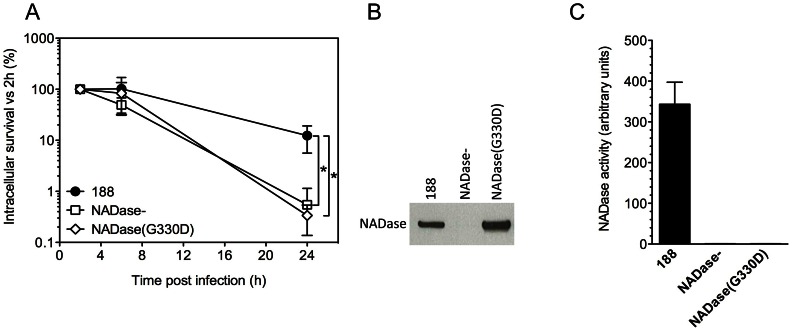
Expression of active NADase plays a central role in the intracellular survival of GAS in oropharyngeal keratinocytes.
A. Intracellular survival of GAS strains 188, 188NADase-, and 188NADase(G330D). Deletion of the gene encoding NADase or inactivation of NADase by the amino acid substitution G330D resulted in a 20- to 40-fold reduction in intracellular survival compared to parent strain 188. *, P<0.001. NADase western blot (B) and activity measurements (C) of culture supernatants from GAS strains 188, 188NADase-, and 188NADase(G330D).